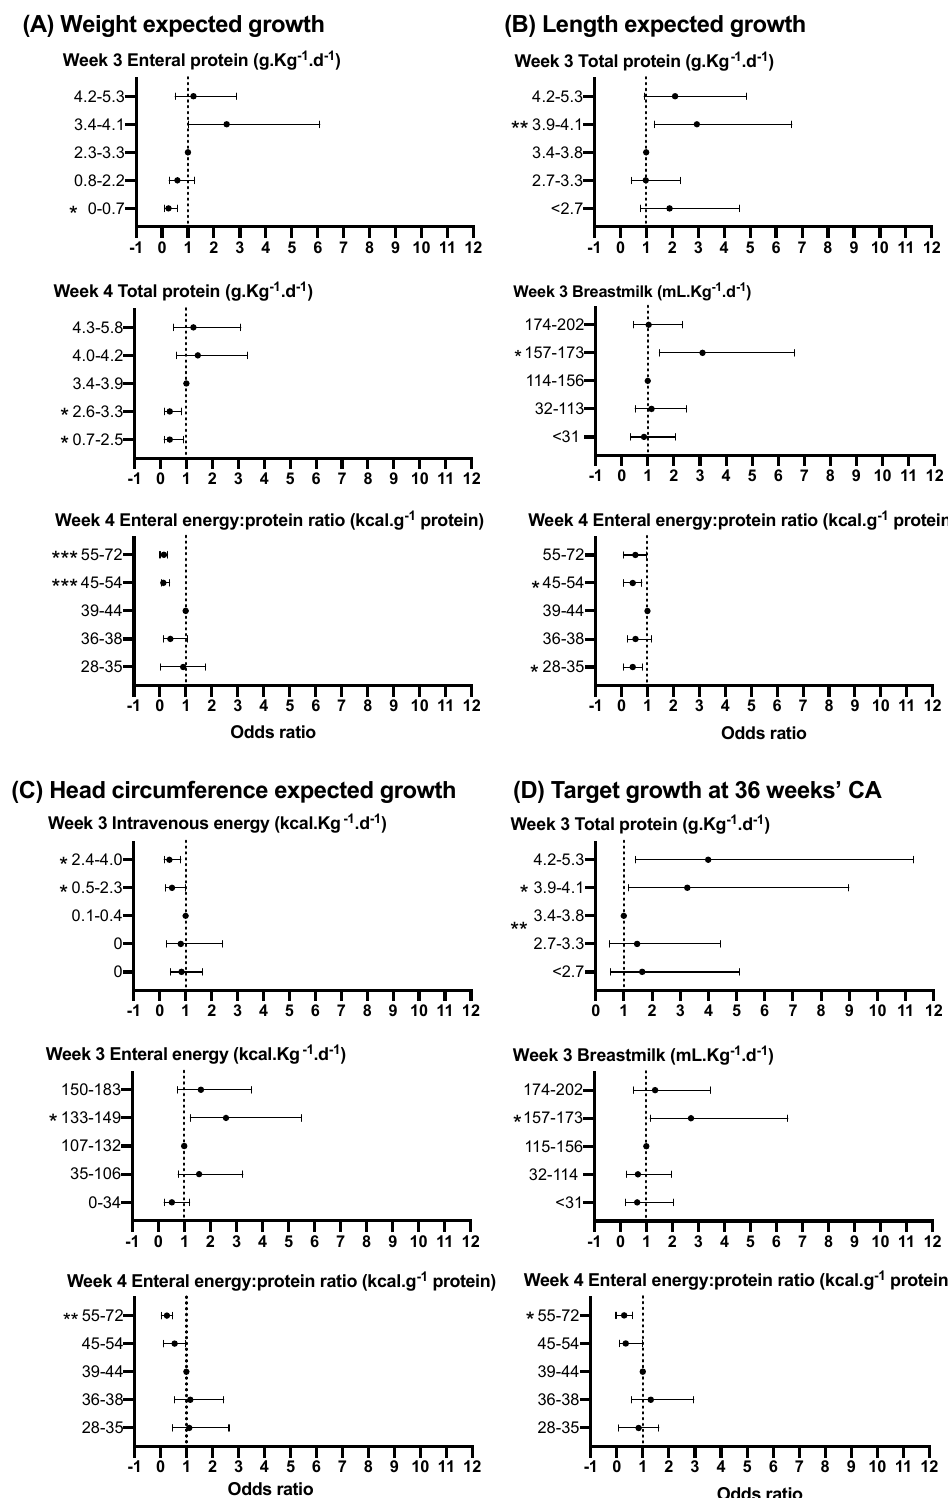
Figure 7. Relationship between selected nutrient intakes in each of the first 4 weeks and expected growth for weight ( A ), length ( B ) and head circumference ( C ), and target growth ( D ). Data are adjusted OR and 95% confidence interval (CI) of achieving expected or target growth for each quintile of intake, where quintile 3 is the referent. Significant p values are shown as * < 0.05, ** < 0.01, *** < 0.001. For full details, see Supplementary Table S2.